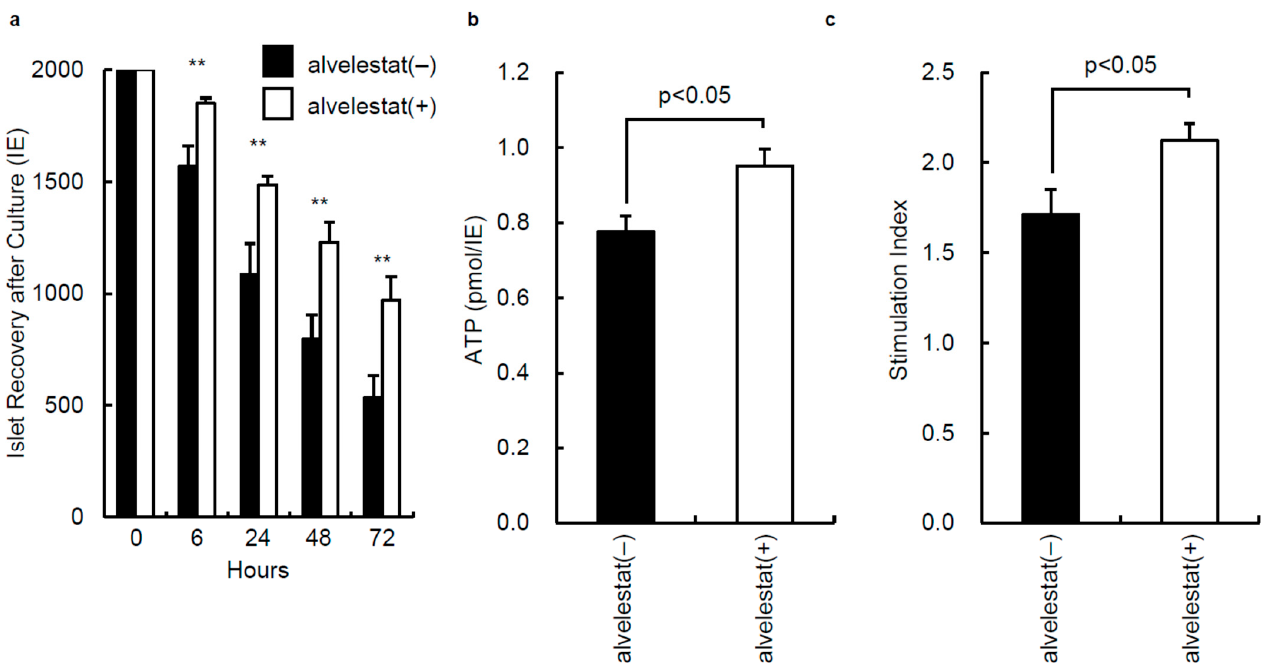
Figure 3. In vitro effect of alvelestat on isolated porcine islet function. ( a ) Number of islets after culturing. Immediately after islet isolation, 2000 IE from each group ( n = 3 each) were cultured for 72 h. The islets were counted to calculate the IE for each group after 6, 24, 48, and 72 h of culturing. ** p < 0.01. ( b ) The adenosine triphosphate (ATP) content in each group was measured using an ATP assay system. Alvelestat (–) group: n = 10; alvelestat (+) group: n = 10. ( c ) The stimulation index was measured in each group. Alvelestat (–) group: n = 10; alvelestat (+) group: n = 10. Data are expressed as the mean ± SE.